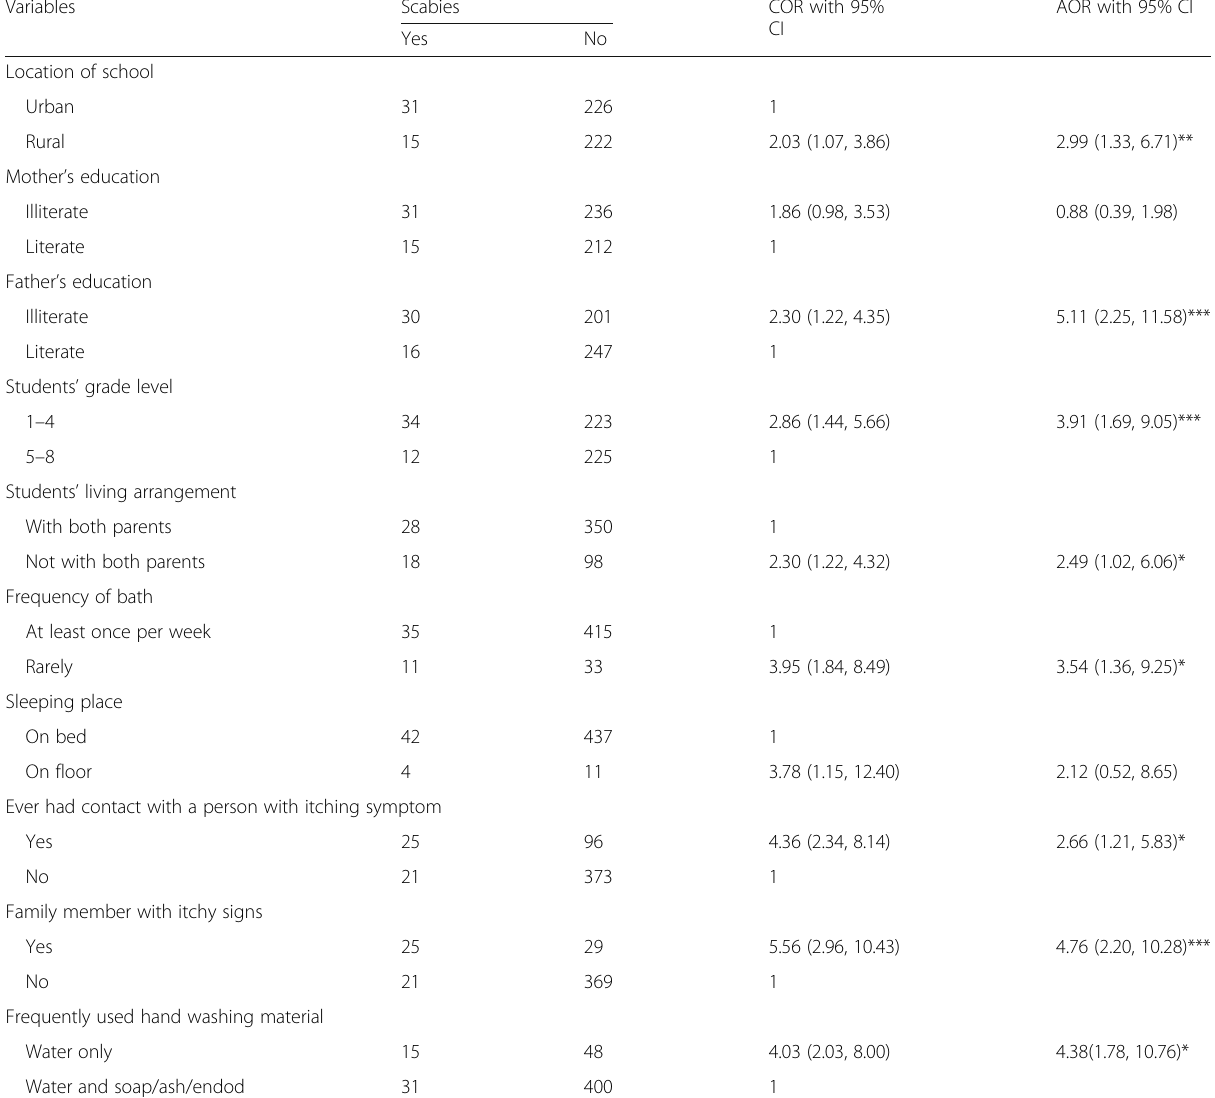
Table 3 Multivariable analysis of predictors for scabies among students in primary school in Dabat district, northwest Ethiopia,